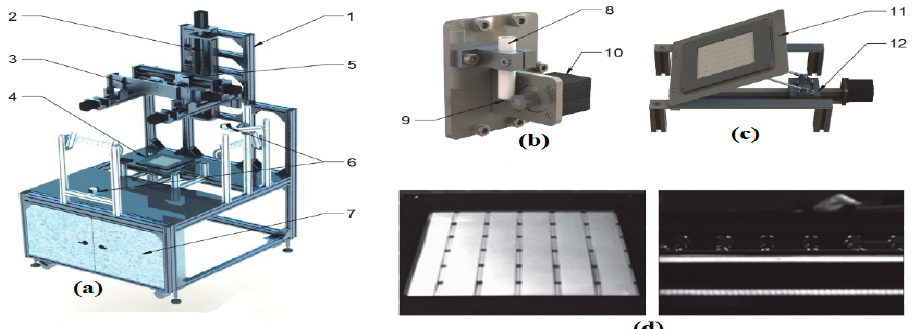
Figure 17. (a) Experiment test bench; (b) Grain release adjuster; (c) Sensing plate slide adjuster; (d) Sensing elements (1—support, 2—height adjustment mechanism, 3—position adjustment